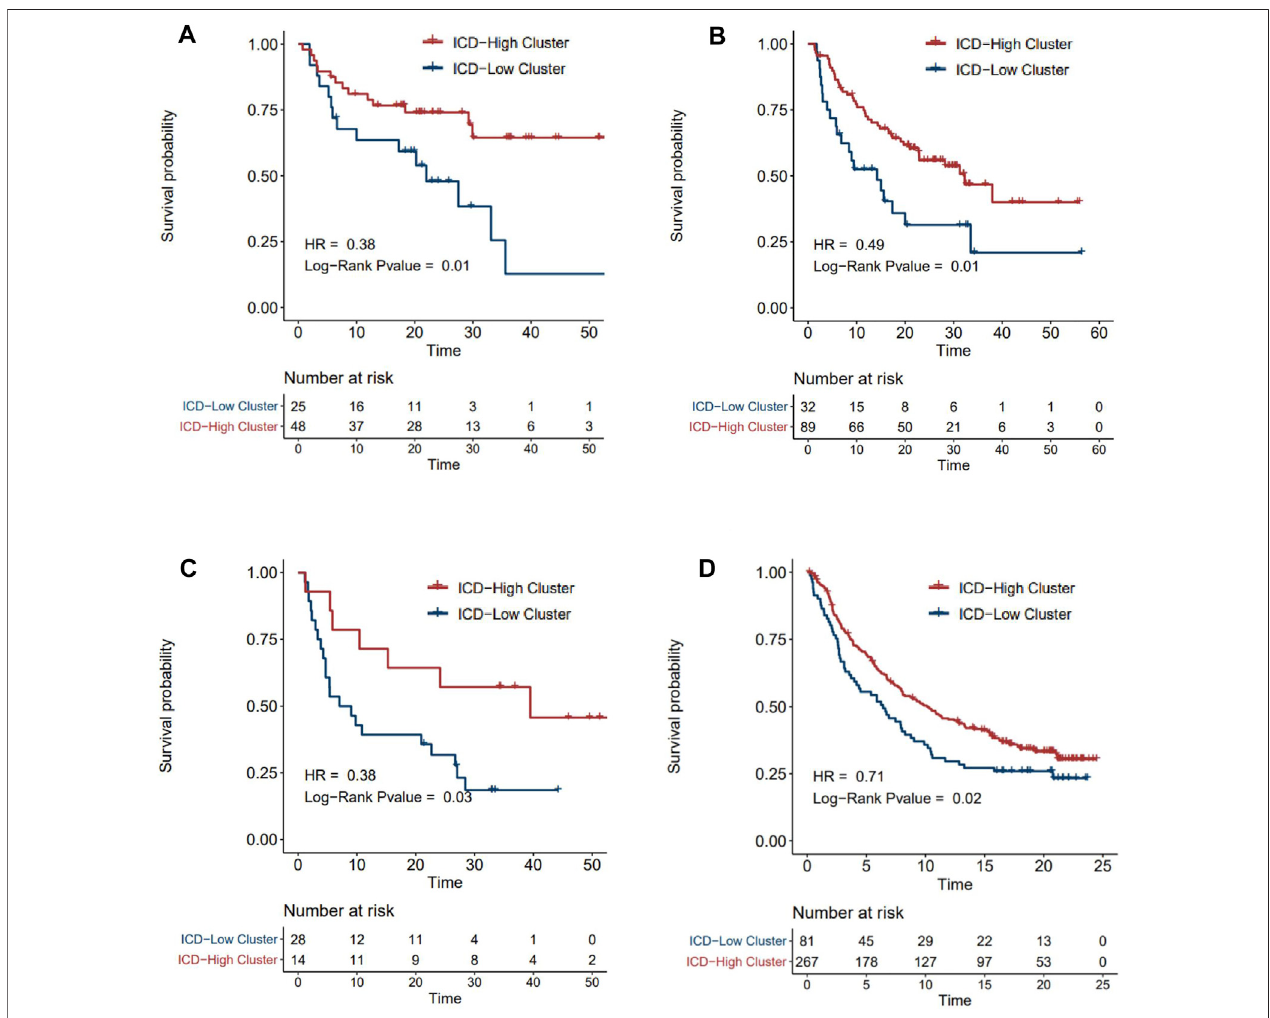
FIGURE 7 | Survival analysis of ICD-score high/low clusters in four immunotherapy cohorts. (A – D) Kaplan – Meier analysis of overall survival in Tuba N Gide et al. ‘ s cohort (A) , David Liu et al. ‘ s cohort (B) , Eliezer MVan Allen et al. ‘ s cohort (C) , and SanjeevMariathasan et al. ‘ scohort (D) (red for theICD-scorehigh cluster; blue for the ICD-score low